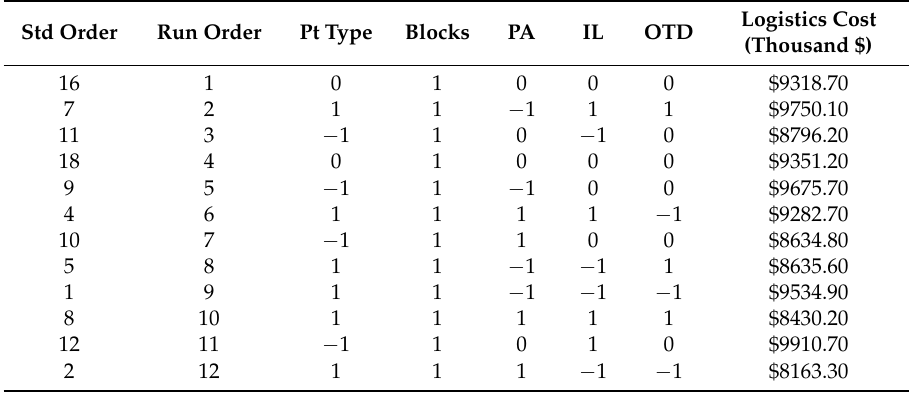
Table 2. Central Composite Design and